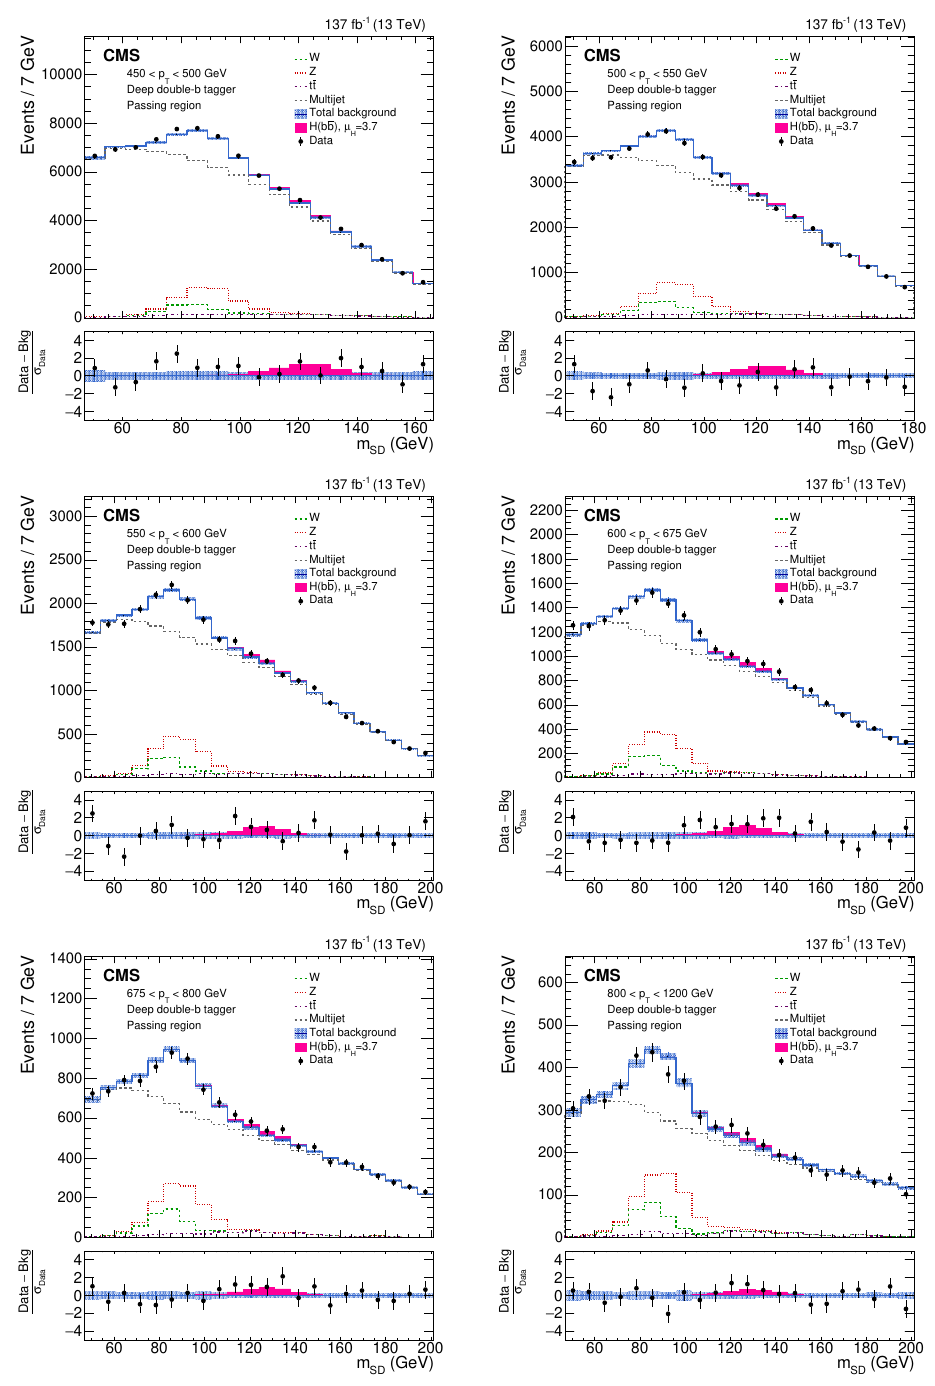
Figure 4 . The observed and fitted background m passing regions. The fit is performed under the signal-plus-background hypothesis with one inclusive H(bb) signal strength parameter floating in all the p systematic uncertainty in the total background prediction. The bottom panel shows the difference between the data and the total background prediction, divided by the statistical uncertainty in the